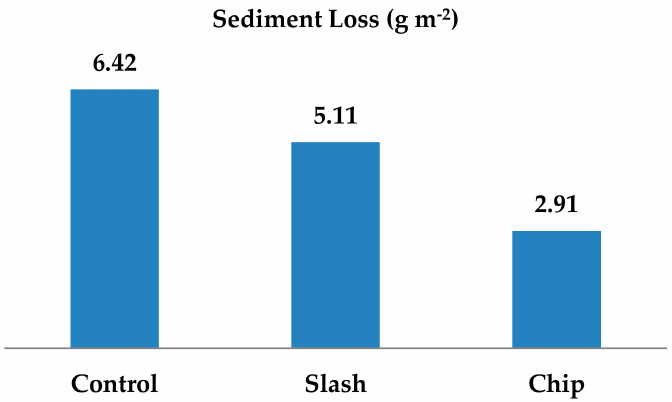
Figure 4. Soil loss in the test